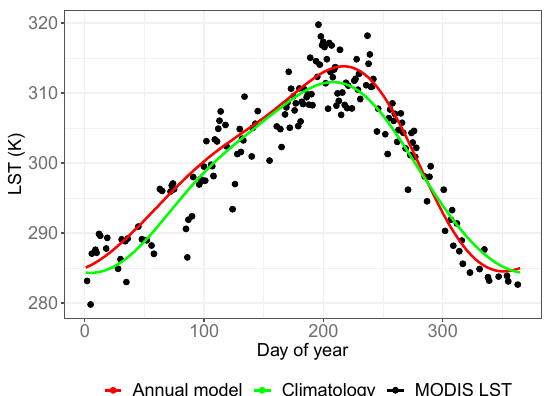
Figure 2. Aqua-MODIS LST data, LST annual model and LST climatology observed in year 2007 in pixel 40°50 ′ 40 ″ N, 14°8 ′ 56 ″ E.